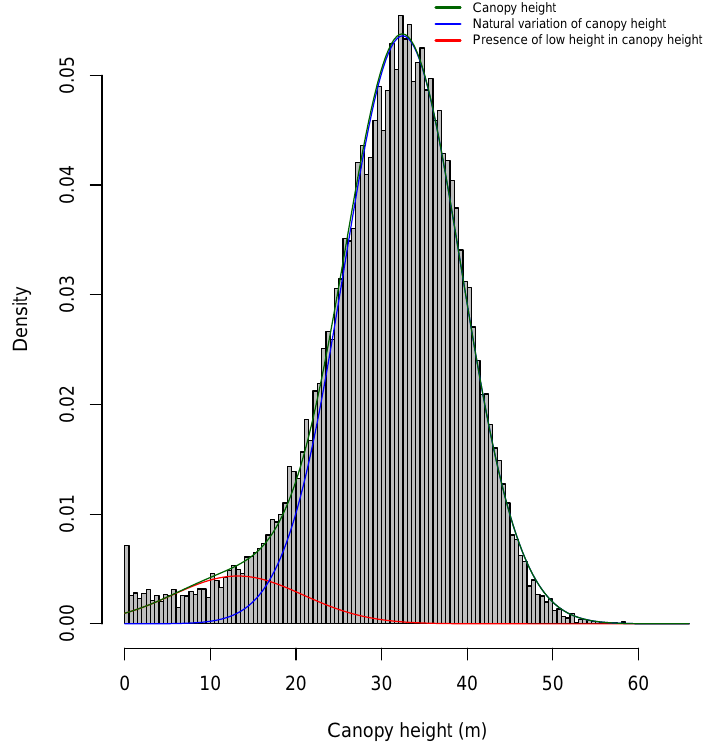
Figure 1. Canopy height distribution. Canopy height considered as a mixture distribution of two ecological features. The first (blue curve) is the natural variation in canopy height, modeled as a normal distribution. The second (red curve) is linked to the presence of low heights in the total canopy height distribution, likely to be due to a forest gap. We set the gap threshold to the 0.001th percentile of the blue curve density, i.e., 11m. Table 1. List of environmental variables, abbreviations, units, and values of the posteriors in univariate models. Parameter Abbreviation Unit Posterior value Confidence interval (CI 95%) Slope Slope ◦ 0.0735 [ − 0.02; 0.15] Terrain ruggedness index TRI – 0.0718 [0.04; 0.10] TOPographic EXposure